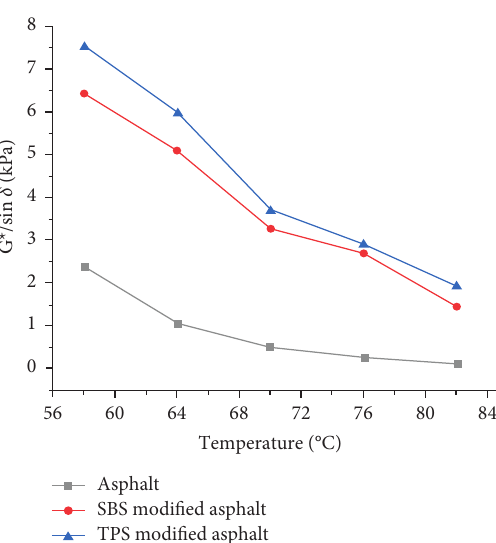
Figure 10: Temperature-rutting factor diagram.